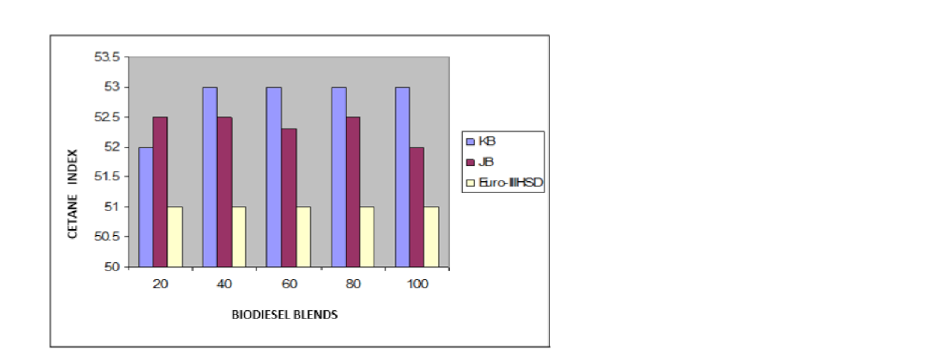
Figure 6. Variation of cetane index of Jatropha curcus and Pongamia pinnata methyl esters blends with EURO-III HSD.